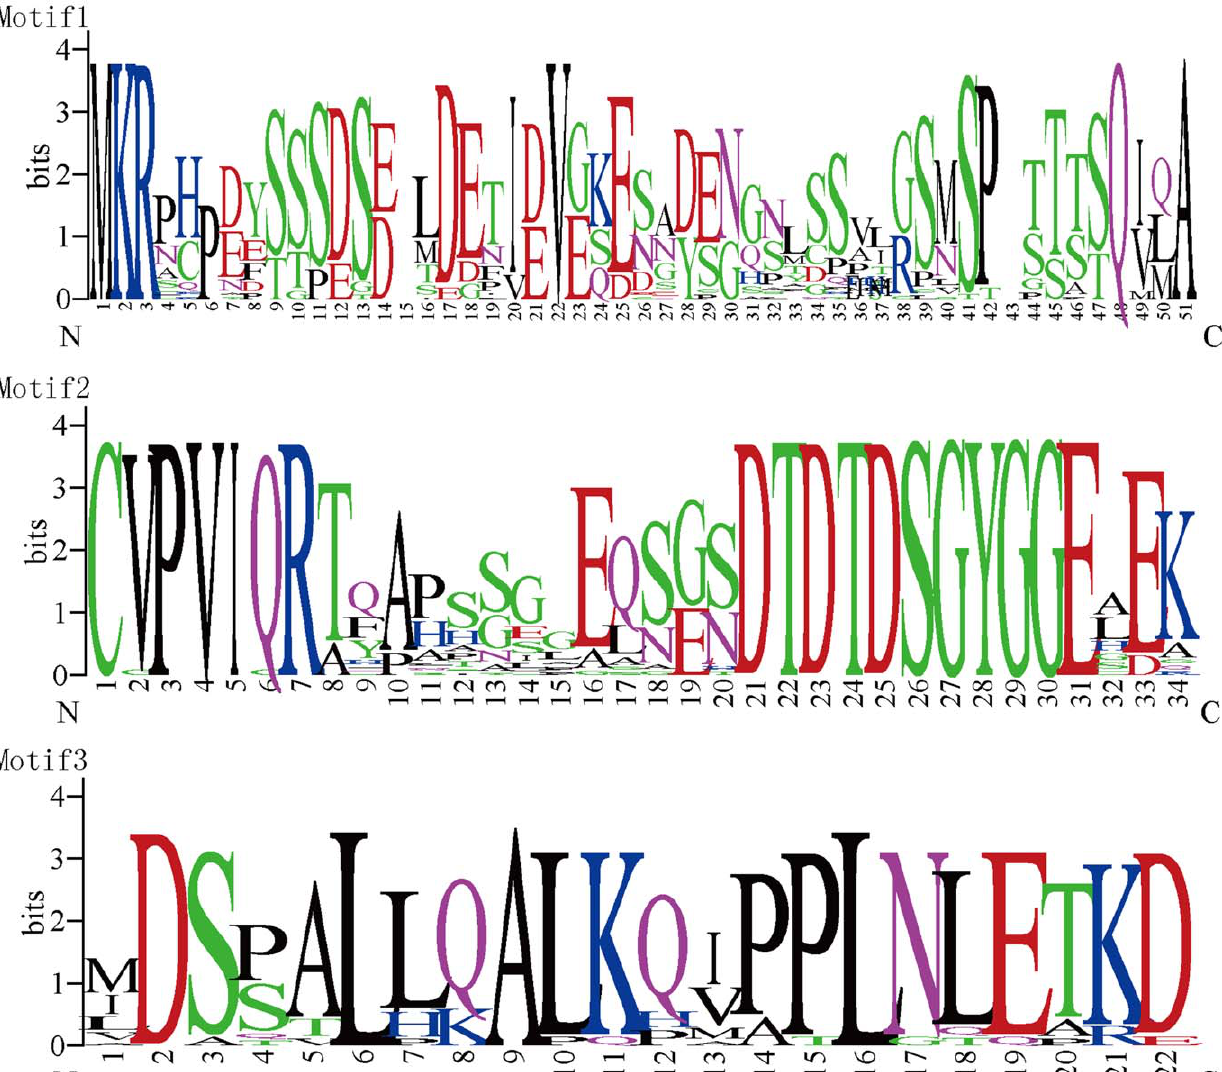
Figure 4. The sequence logos of three conserved motifs in subgroups of HES/HEY genes. The Motif 1 was created using an alignment of HEY1/2/L sequences near bHLH domain. The similar process was used to get Motif 2 (DEC1/2 sequence near Orange domain) and Motif 3 (DEC1 sequence in C-terminal). The overall height of each stack indicates the sequence conservation at that position, whereas the height of symbols within each stack reflects the relative frequency of the corresponding amino